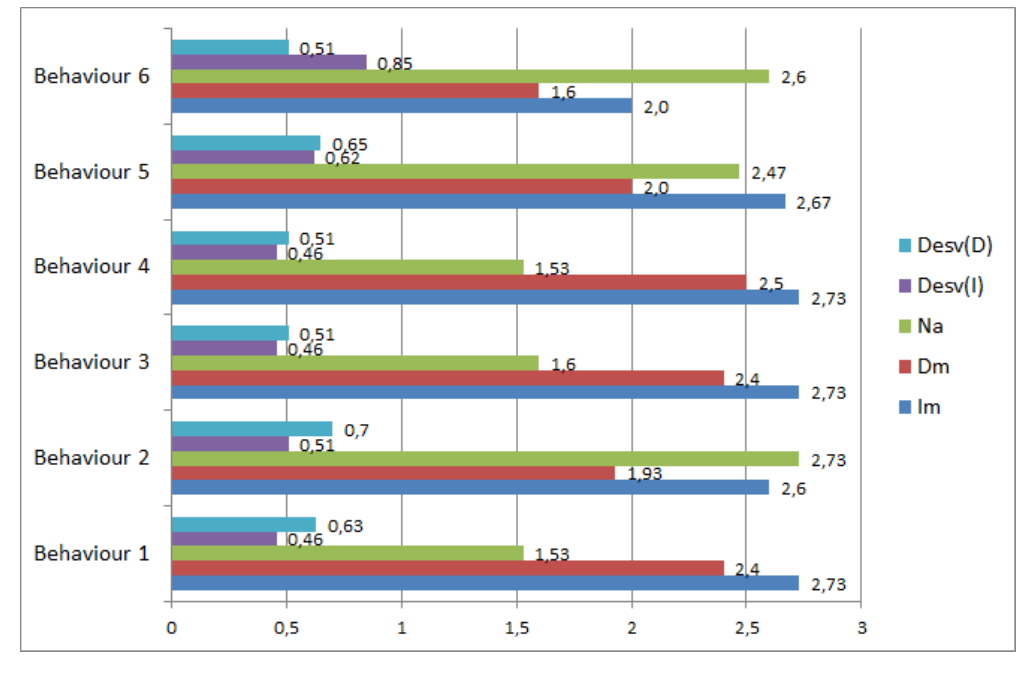
Figure 1. Effective listening. Table 4. List of